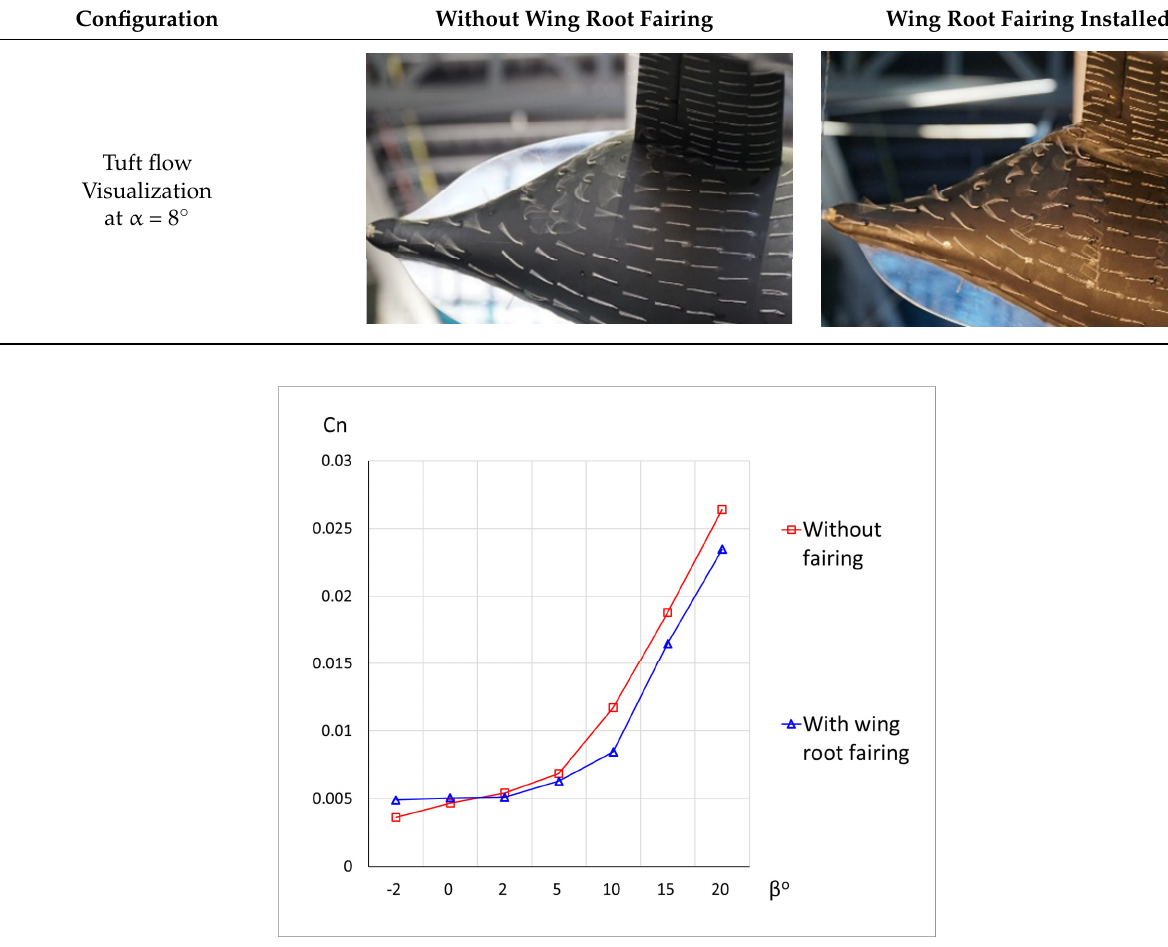
Table 6. Aft fuselage tuft flow visualization with wing root fairing.